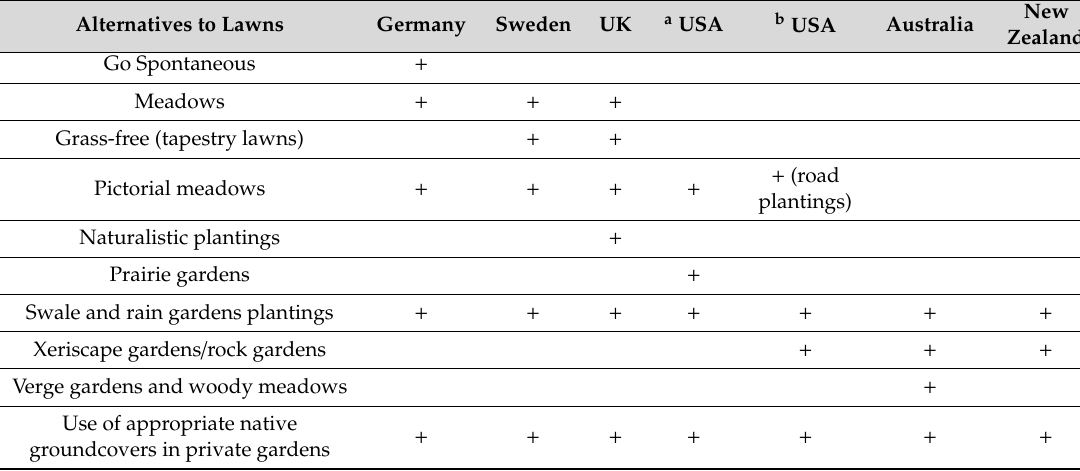
Table 3. Alternatives to